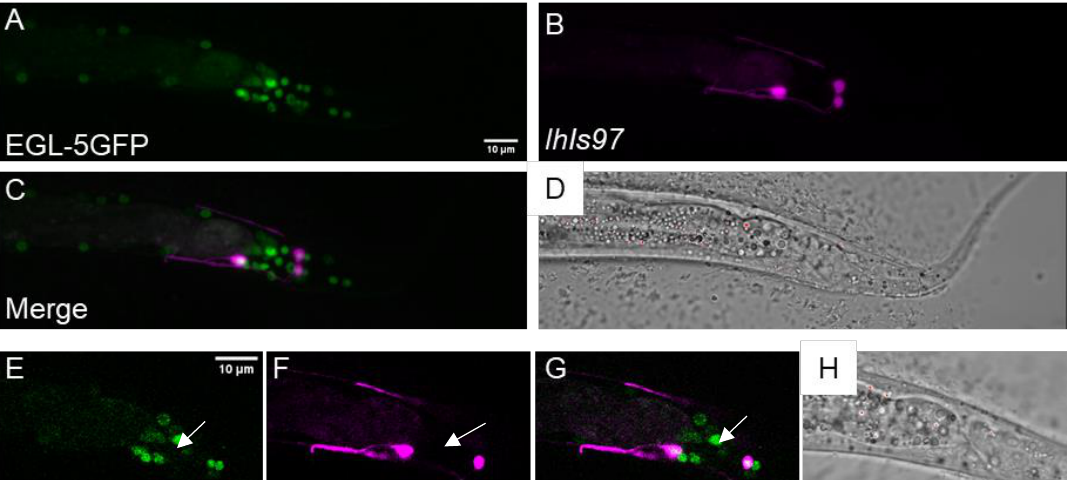
Figure 4. egl-5 is expressed in VD13 and the LUA neurons. ( A ) EGL-5::GFP, under the control of the egl-5 promoter, was observed in the posterior of the animal. ( B ) lhIs97 expresses RFP in VD13 and the LUAs. ( C ) The signal is co-incident in both cells, suggesting that egl-5 is expressed in both VD13 and the LUAs. ( D ) A transmitted light image of the region. ( A – D ) A z-projection through the entire animal. E – H ) A single plane image through the center of VD13. The arrow indicates VD13.